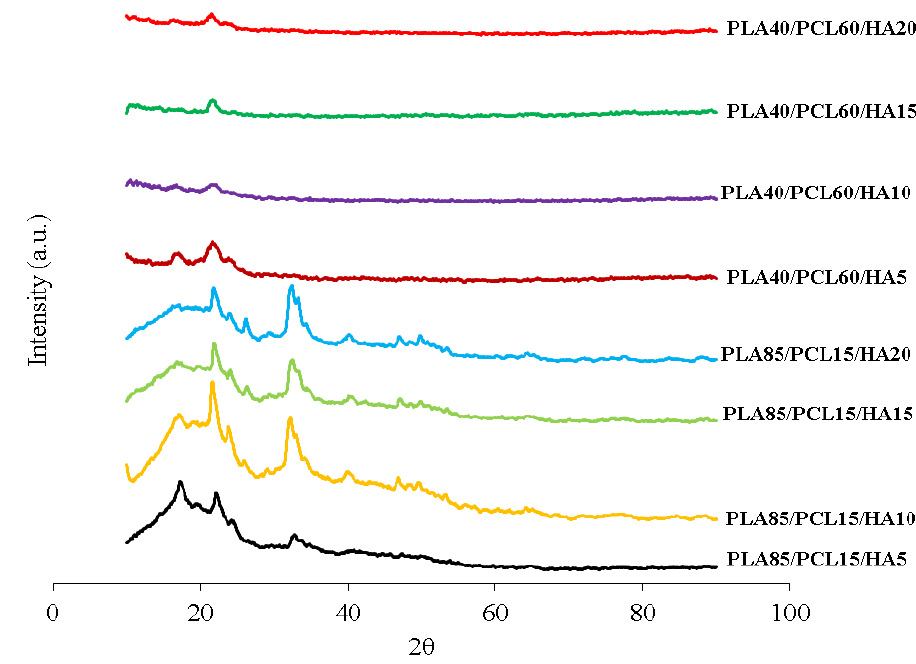
Figure 4. XRD patterns of the PLA/PCL/HA biocomposites.